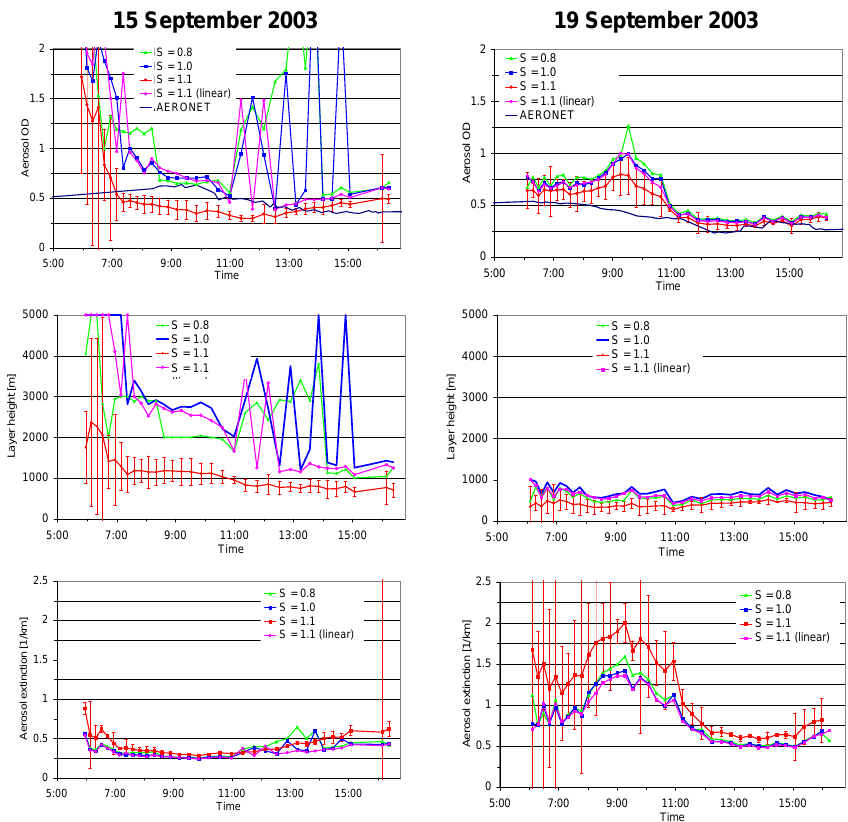
Fig. 5. Diurnal variation of the AOD (top), layer height L (middle) and aerosol extinction ε (bottom) for different shape parameters (southern telescope). For comparison, also the AOD from sun photometer measurements (AERONET) at Ispra are shown (dark blue line). Except the early morning of 15 September 2003 (before about 07:00), both days were cloud free. Error bars (for 95% confidence intervals) are determined within the inversion procedure; they are exemplarily shown for the retrieval assuming an elevated layer (two-layer profile). A similar figure, but with error bars for box profile inversion is shown in the Supplement (Fig. S3).